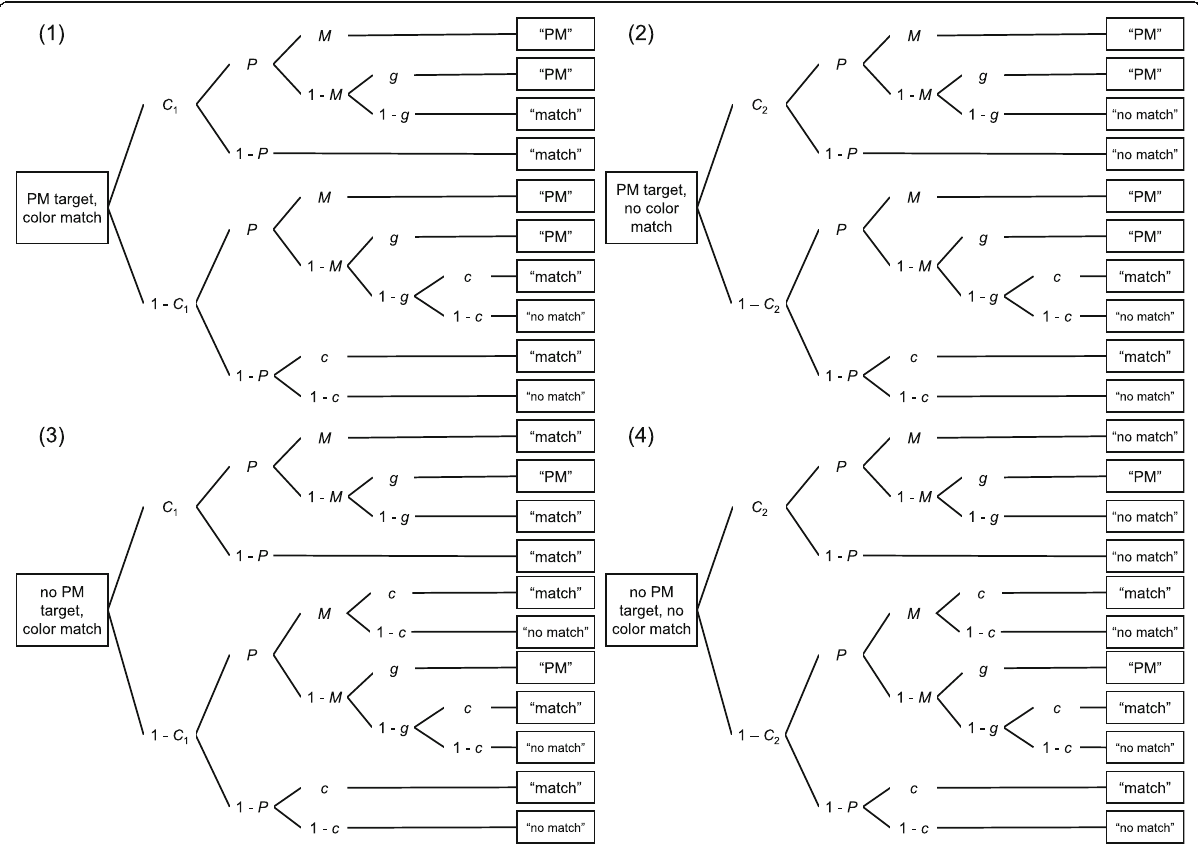
Fig. 3 The multinomial processing tree model of event-based prospective memory by Smith and Bayen (2004). C 1 : probability to detect that the colors match; C 2 : probability to detect that the colors do not match; P : prospective component; M: retrospective component; c : probability to guess that the colors match; g : probability to guess that the word is a prospective-memory target. Adapted from “ A multinomial model of event- based prospective memory ” by R. E. Smith and U. J. Bayen, 2004, Journal of Experimental Psychology: Learning, Memory, and Cognition, 30 , p.